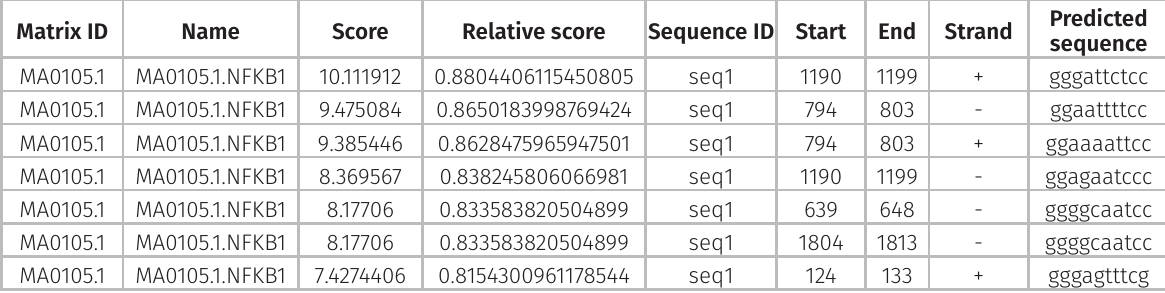
Figure 1. NF-κB-induced miR-518a-5p is overexpressed in preeclamptic placenta and induces the NF-κB pathway. a) MiR-518a-5p expression in normal (n = 4) and preeclamptic (n = 4) placenta was revealed by In Situ Hybridization. b) and c) Enrichment of miR-518a-5p promoter precipitated by anti-NF-kB p50, anti-NF-kB p65, and anti-NF-kB p52 in preeclamptic placenta (n = 4) and HTR8/SVneo cells (n = 3) was measured by ChIP assays followed by PCR. **p<0.01, ***p<0.001 vs anti-IgG. One way ANOVA followed by Dunnett’s post hoc test was performed. d) MiR-518a- 5p in HTR8/SVneo cells after treatment of QNZ was detected by PCR and normalized to U6. **p<0.01 vs Control. Student’s t test was performed. e) NFkB p50, p65, p52 and their phosphorylated protein levels in HTR8/SVneo cells after treatment of miR-518a-5p mimics or inhibitor. N = 3 for the in vitro assays. Table II. Binding of NFKB1 on miR-518a-5p